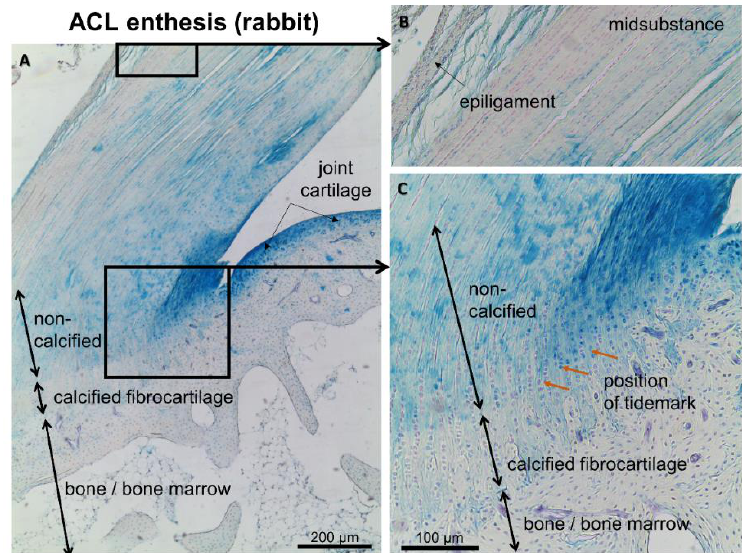
Figure 5. Enthesis of the unaffected rabbit ACL . Three different zones of the enthesis are shown using Alcian blue staining to depict sulfated glycosaminoglycan deposition (blue). ( A ): overview. ( B ): mid-substance. ( C ): enthesis zones.